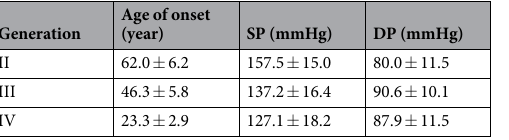
Table 1. comparison of age of onset and blood pressure of the individuals on maternal